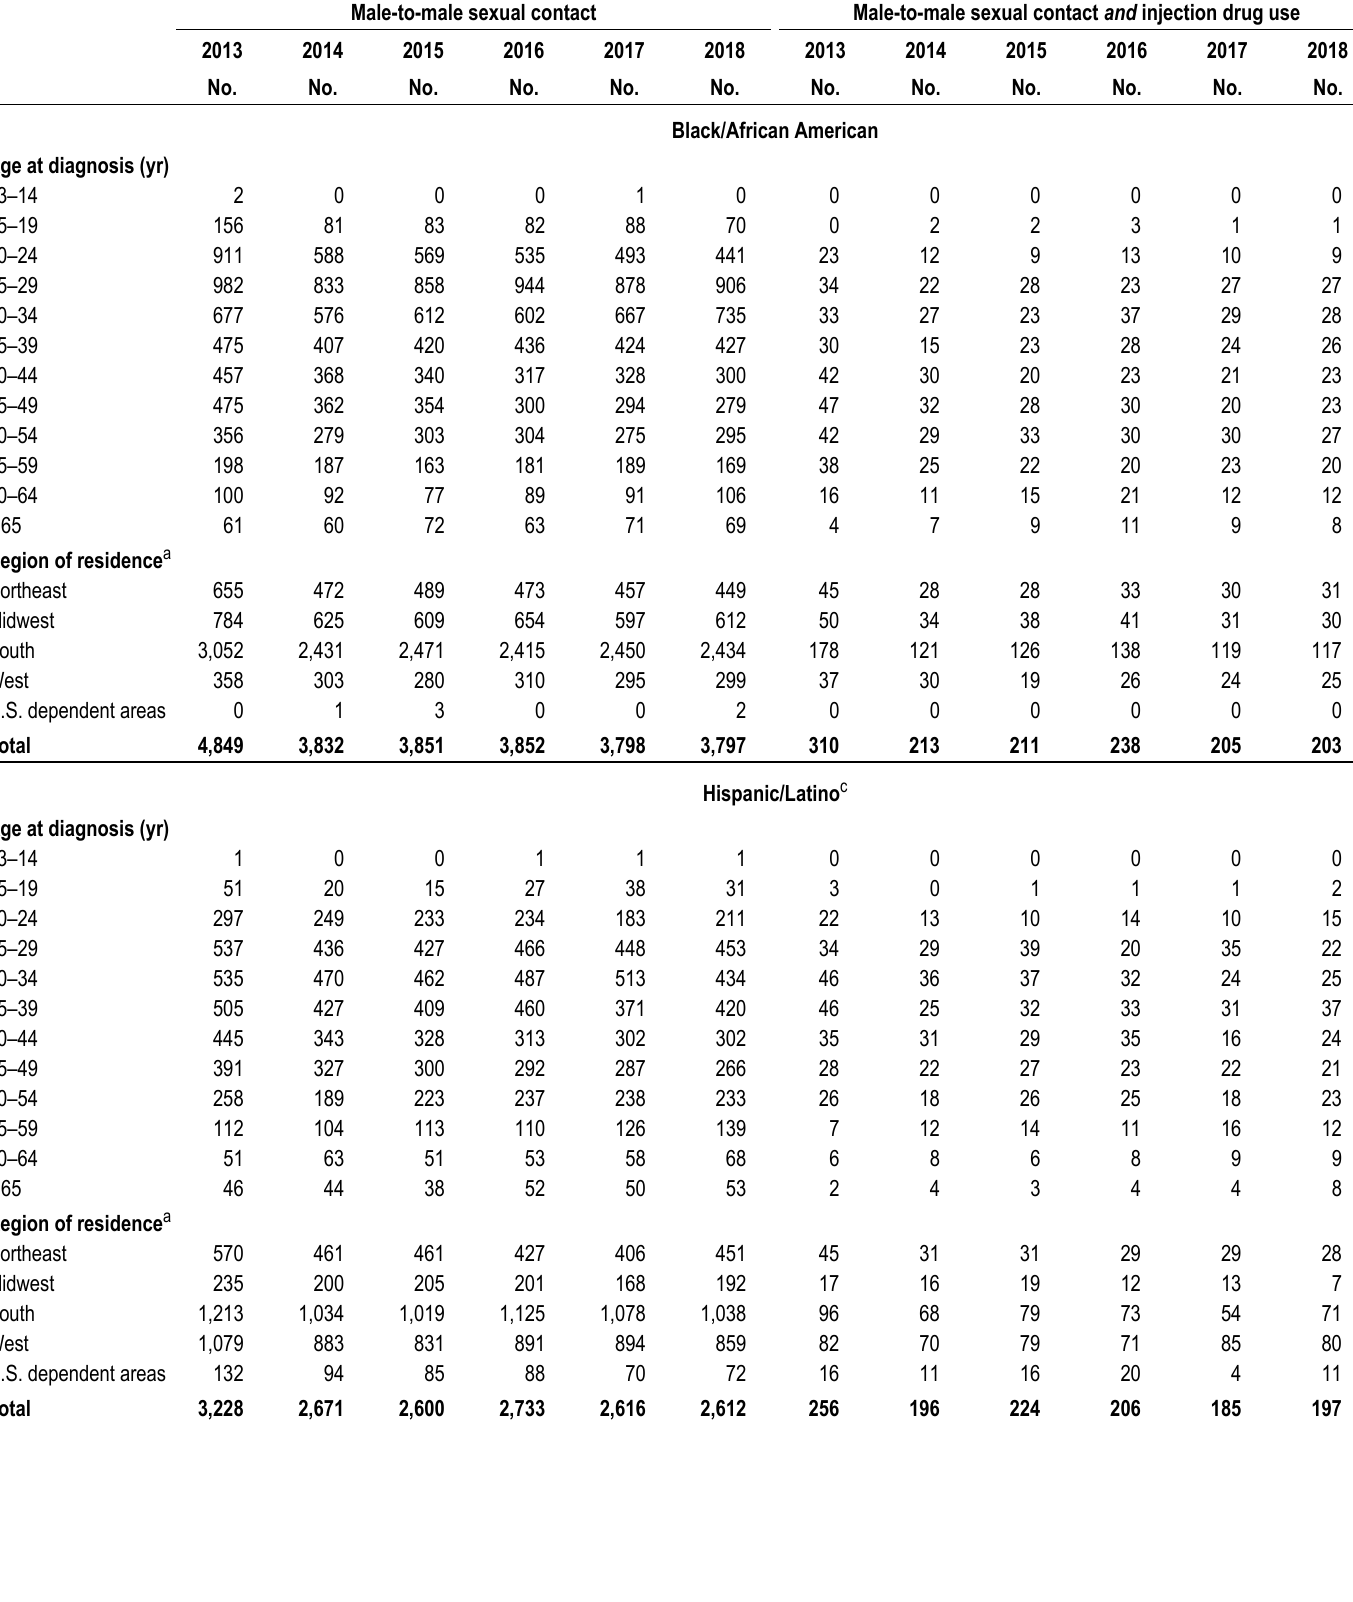
Table 10b. Stage 3 (AIDS) attributed to male-to-male sexual contact and male-to-male sexual contact and injection drug use, by selected characteristics, 2013–2018—United States and 6 dependent areas (cont) Male-to-male sexual